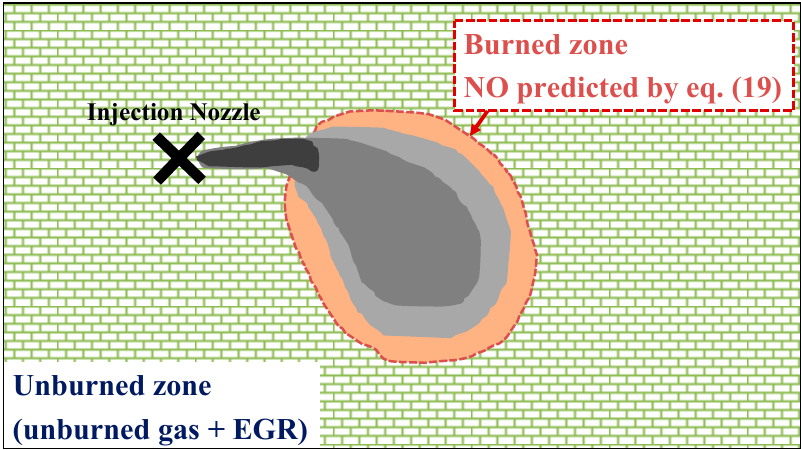
Figure 5. Schematic of the in-cylinder burned and unburned zone.